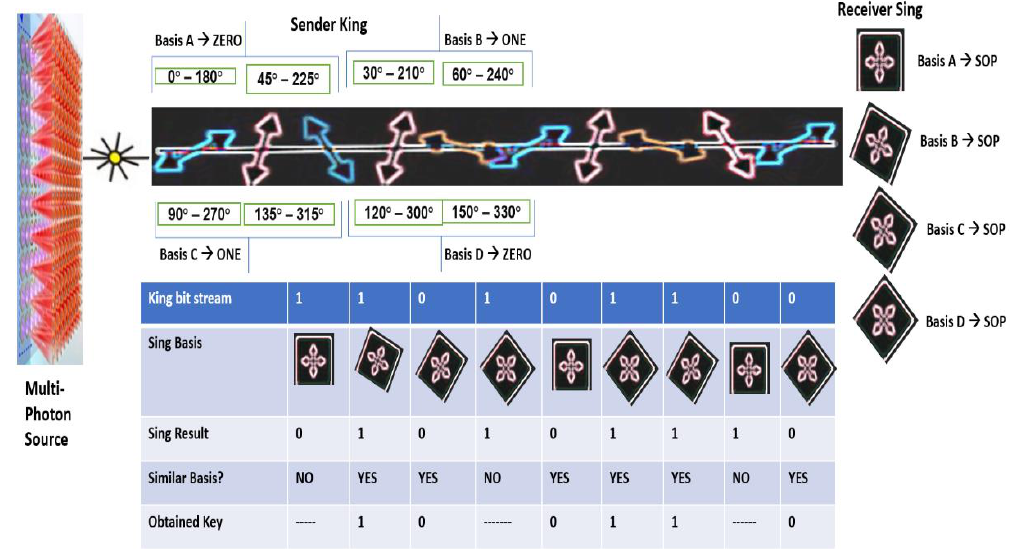
Figure 1. Design and construction of the proposed multi-bit QKD. King uses four conjugated basis to encode an arbitrary stream of bits. Individual bits where King and Singh cast off the identical basis is considered as the obtained final key.